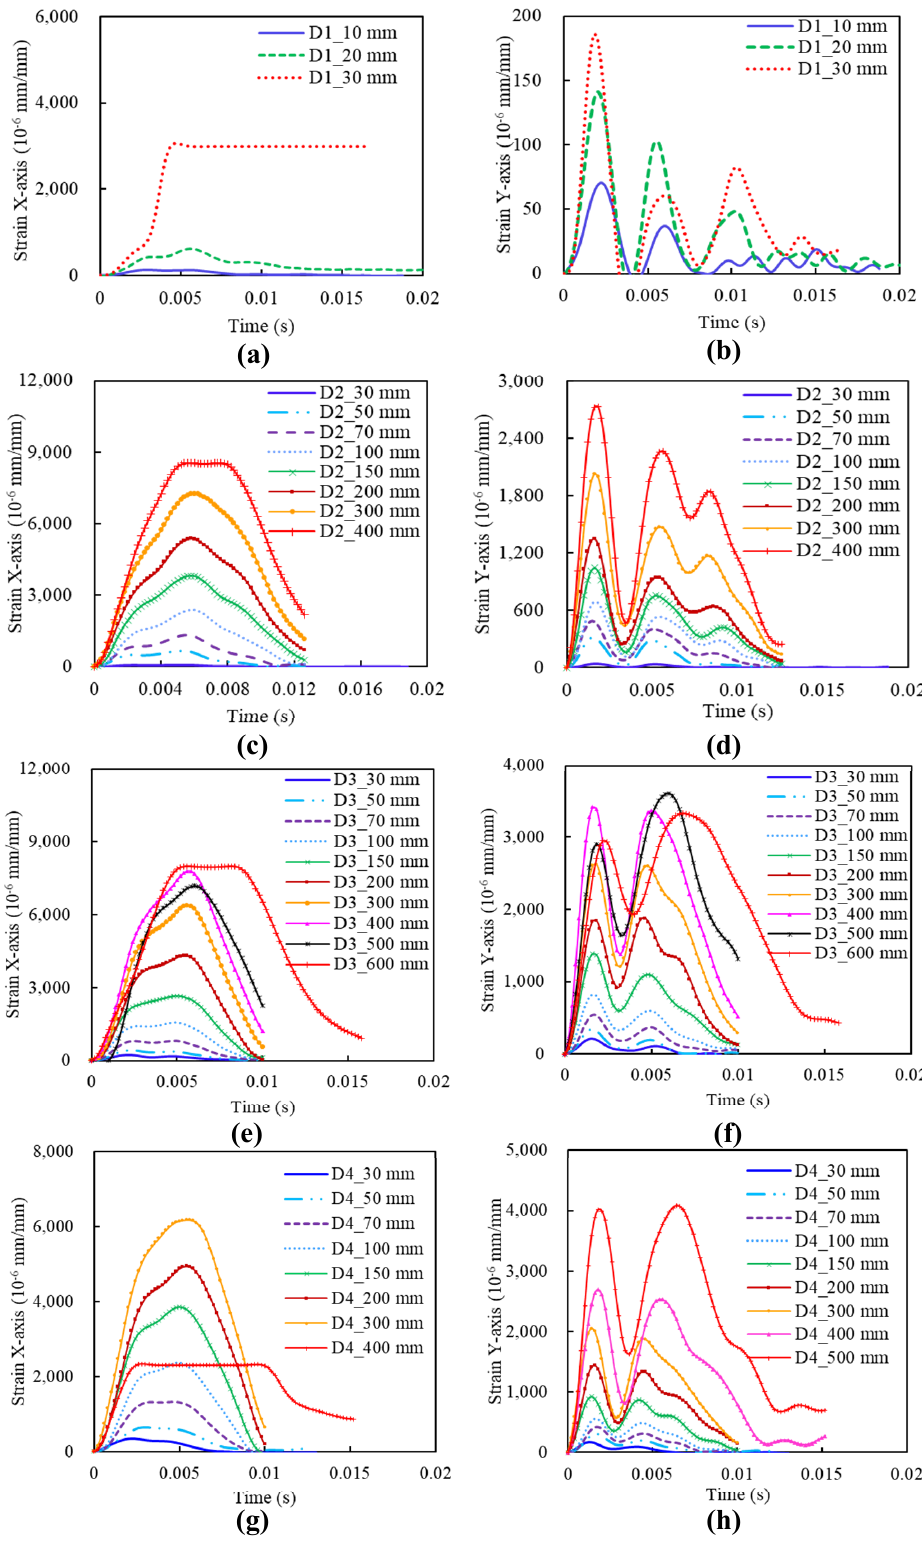
Figure 13. Strain time histories under different impact height for Group D: ( a ) X-axis strain of specimen D1; ( b ) Y-axis strain of specimen D1; ( c ) X-axis strain of specimen D2; ( d ) Y-axis strain of specimen D2; ( e ) X-axis strain of specimen D3; ( f ) Y-axis strain of specimen D3; ( g ) X-axis strain of specimen D4; ( h ) Y-axis strain of specimen D4.